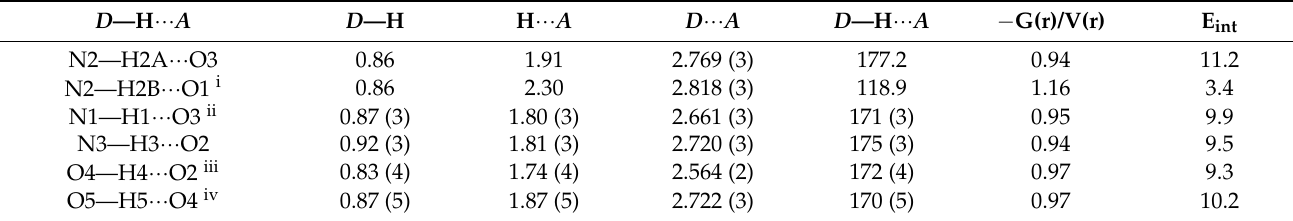
Table 5. Hydrogen-bond geometry (Å, ◦ ) and topological analysis for compound ( V ). E int is reported in kcal/mol. For additional details concerning QTAIMS results see Tables S11 and S12 in the Supporting Information.